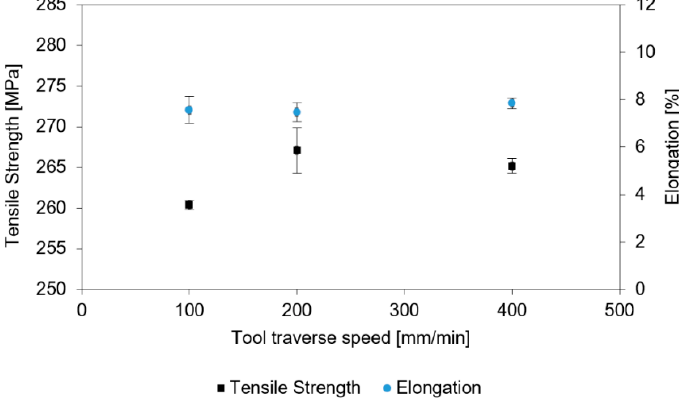
Figure 8. Established mechanical properties for joints obtained with the tool rotation speed of 400 rpm.